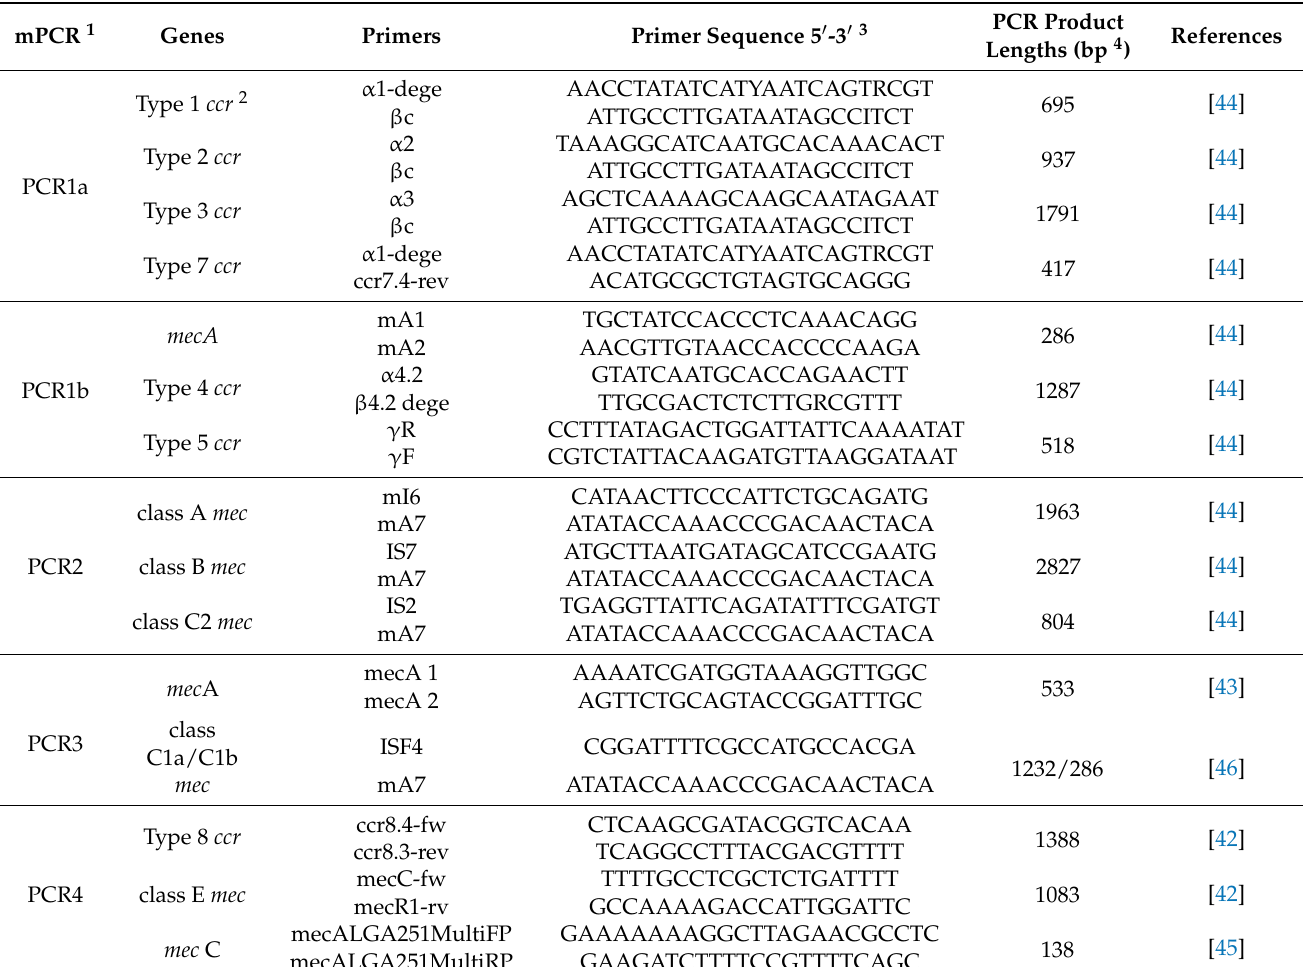
Table 4. Primers used for the SCC mec typing by multiplex